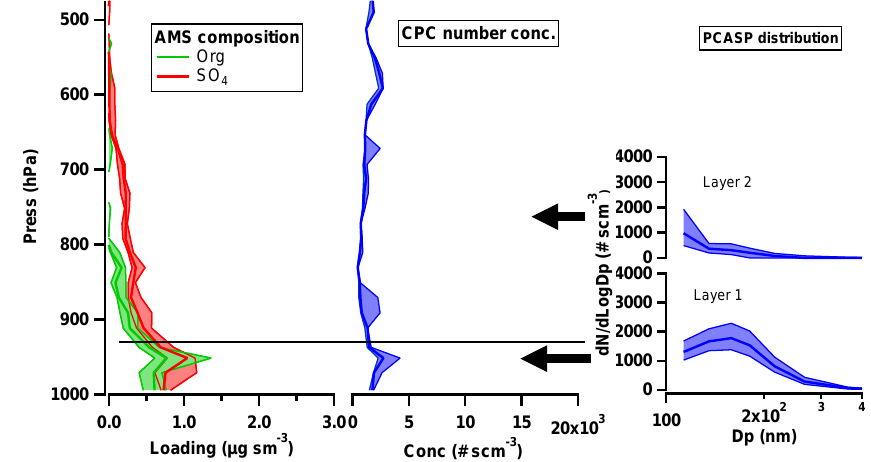
Fig. 6. Averaged altitude profiles (median and interquartile ranges) organic and sulphate aerosol loading, aerosol number concentration and number/size distributions for different layers. Averages comprise three profiles (during the MCS-dominated regime) from flight B389 in the morning of 17 July 2008.